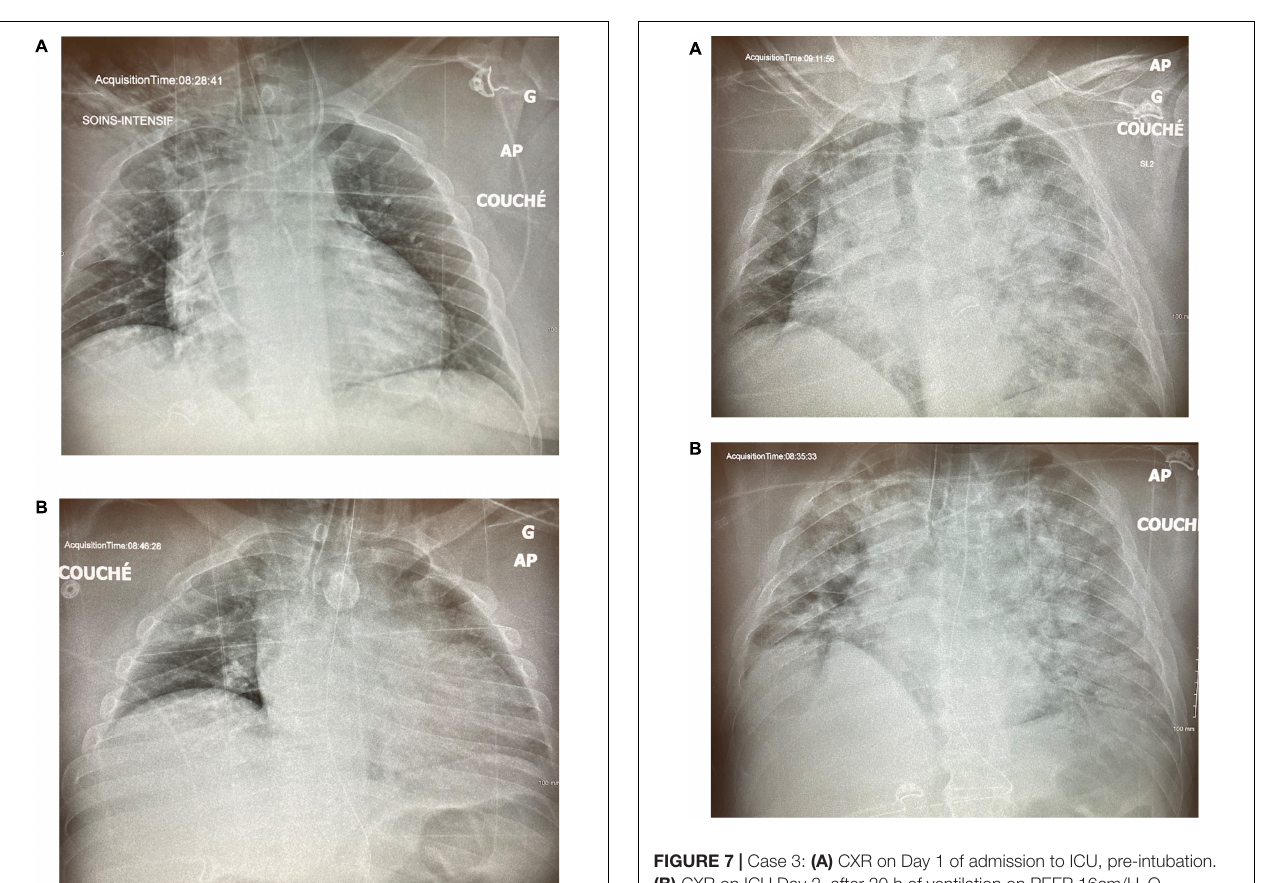
FIGURE 7 | Case 3: (A) CXR on Day 1 of admission to ICU, pre-intubation. (B) CXR on ICU Day 2, after 20 h of ventilation on PEEP 16cm/H 2 O. Case 3—Third